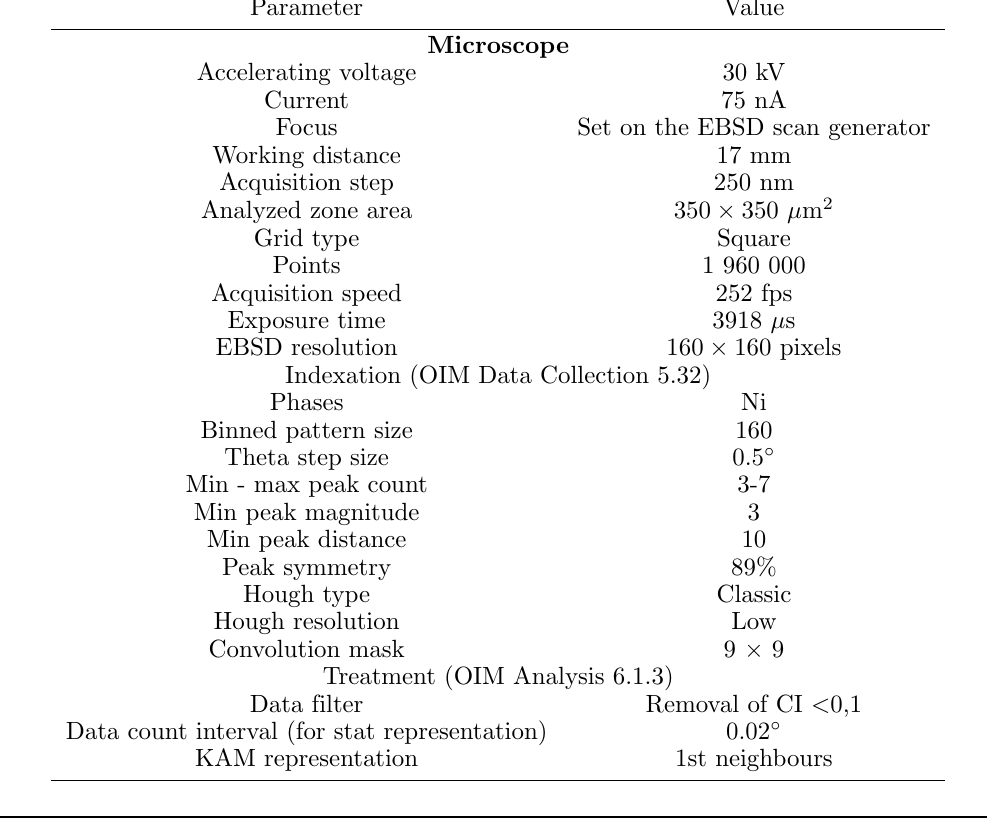
Table A.1. Acquisition parameters of the experimental EBSD maps.